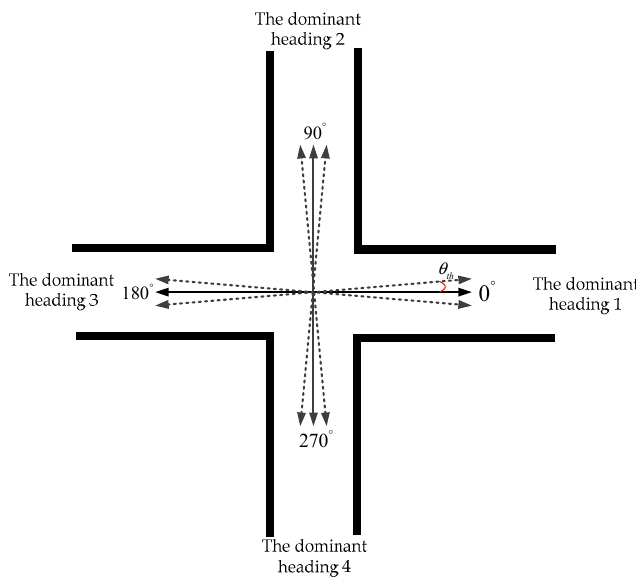
Figure 5. Four dominant directions are pre-defined with the fact that most corridors in buildings are straight and so are most walls and sidewalks alongside which a person might walk.